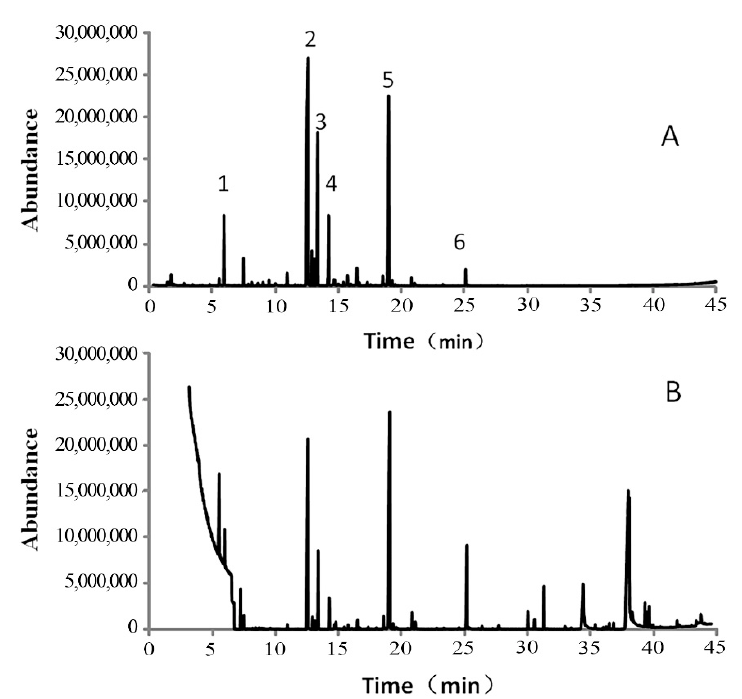
Figure 1. GC-MS total ion chromatograms of garlic essential oil. ( A ) Diluted with n-hexane; ( B ) volatile compounds sampling by HS-SPME method. 1, diallyl sulfide (DAS); 2, diallyl disulfide (DADS); 3, disulfide, dipropyl; 4, trisulfide, methyl 2-propenyl; 5, trisulfide, di-2-propenyl (DATS); 6, tetrasulfide, di-2-propenyl.